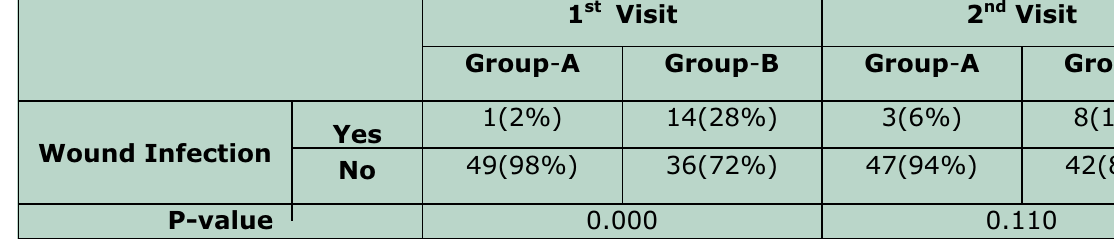
st nd Table-IV: Wound infection at 1 & 2 visit in treatment group.